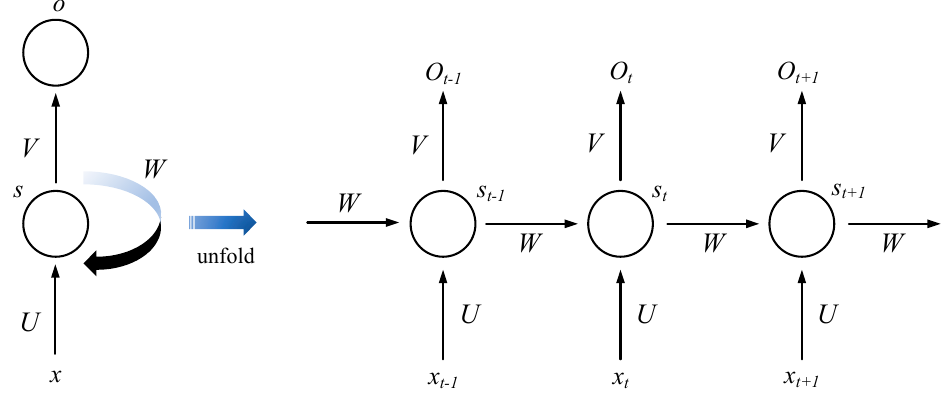
Figure 2. Schematic diagram of recurrent neural network. The output layer and hidden layer of RNN are calculated as follows.